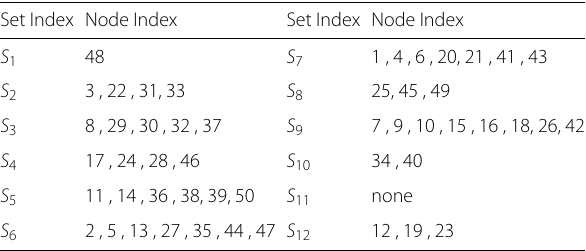
Table 3 The result of the classified set S k ( k = 1, 2, . . . , r ) for the 50-node network